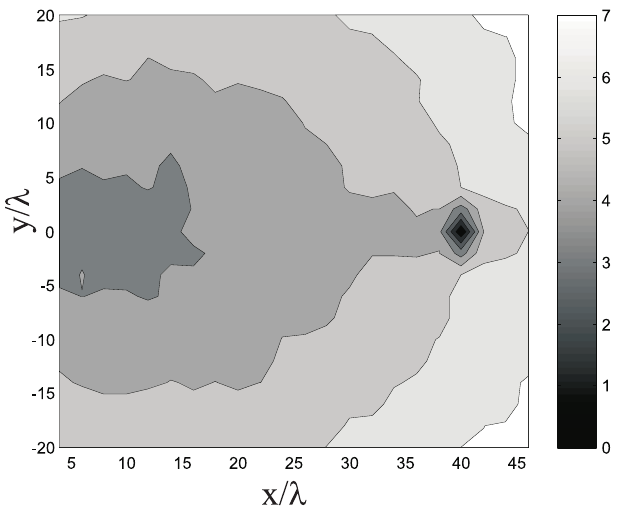
Figure 6. ¯ ∆ I [bits/s/Hz], P s = 4 W, P i = 7